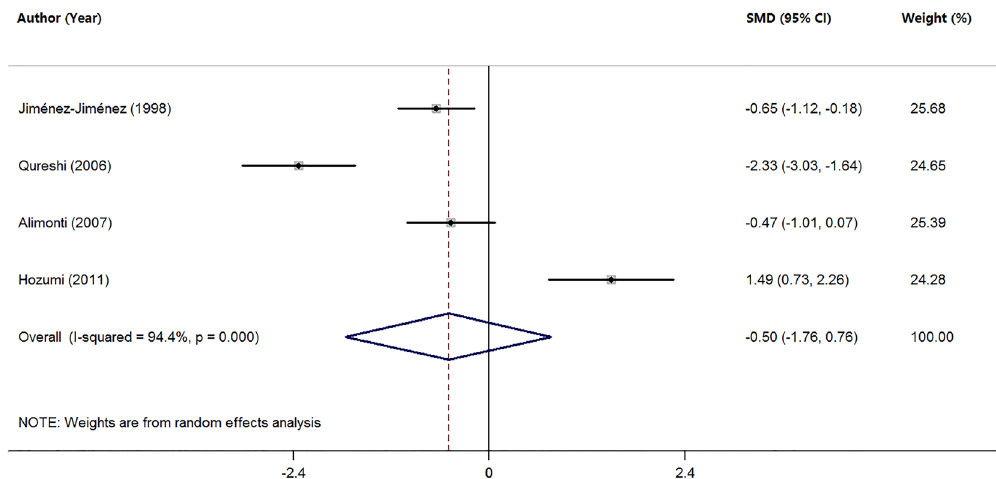
Figure 5. Forest plot for random-effects meta-analysis on differences in CSF Zn between PD patients and health controls. 3 studies encompassing a sample of 229 subjects. The horizontal lines represent 95% CI. The sizes of the shaded squares are proportional to study weight. SMD, Standardized mean difference; CI, confidence